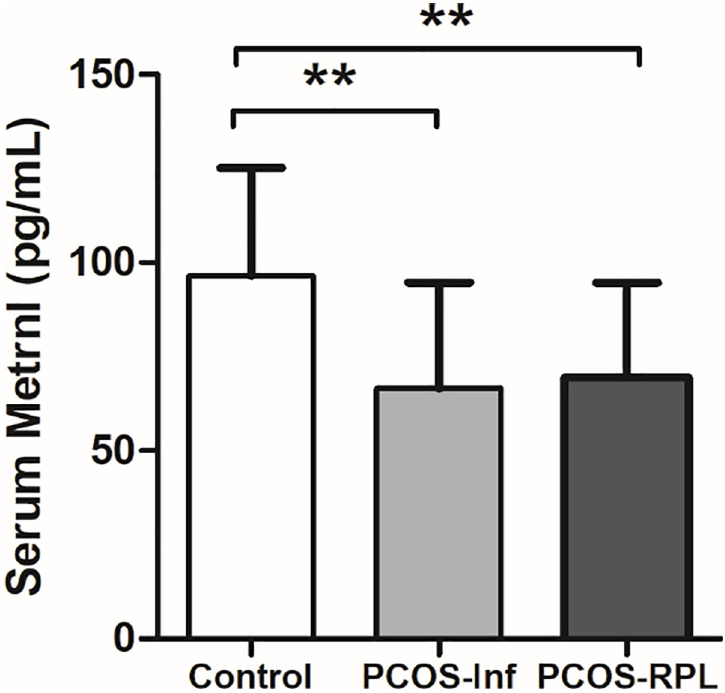
Fig 2. Serum levels of Metrnl protein (pg/mL) in control vs. infertile PCOS vs. PCOS-RPL subgroups (96.47 ± 28.72, 66.57 ± 28.14, and 69.39 ± 25.25, respectively, P < 0.001). PCOS: Polycystic ovary syndrome; PCOS-Inf: Infertile PCOS; RPL: Recurrent pregnancy loss.